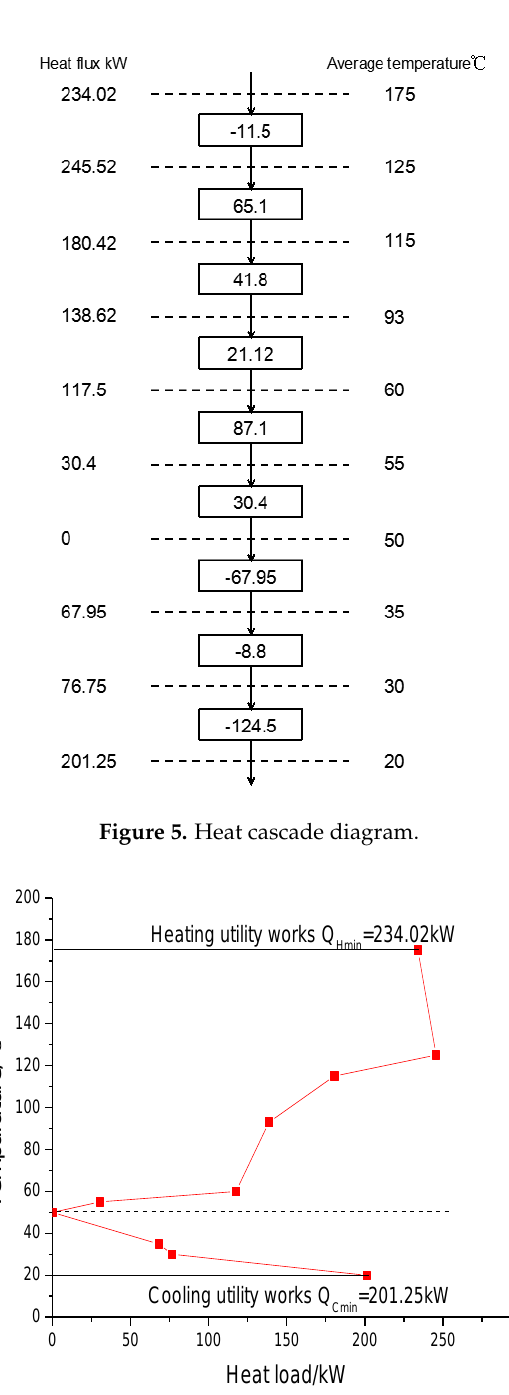
Figure 6. Grand composite curves.